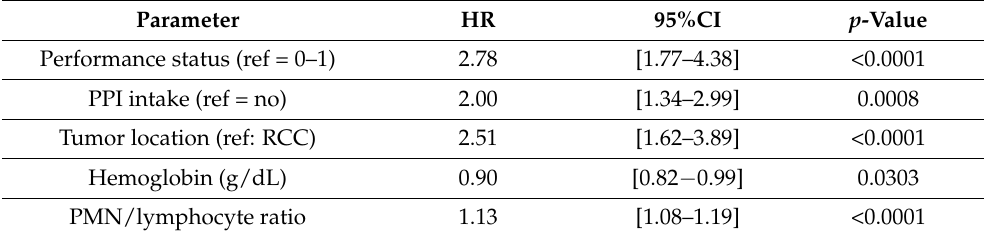
Table 3. Multivariable analysis for those factors associated with overall